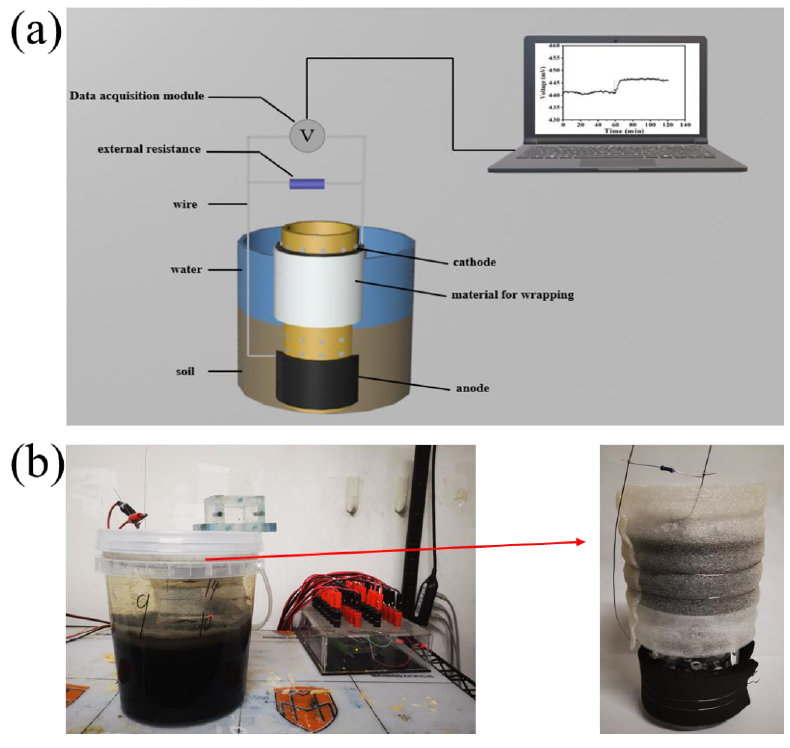
Figure 1. The schematic diagram ( a ) and prototype ( b ) of the SMFC-based sensor. The red arrow in ( b ) indicates the anode and cathode assembly of the SMFC.